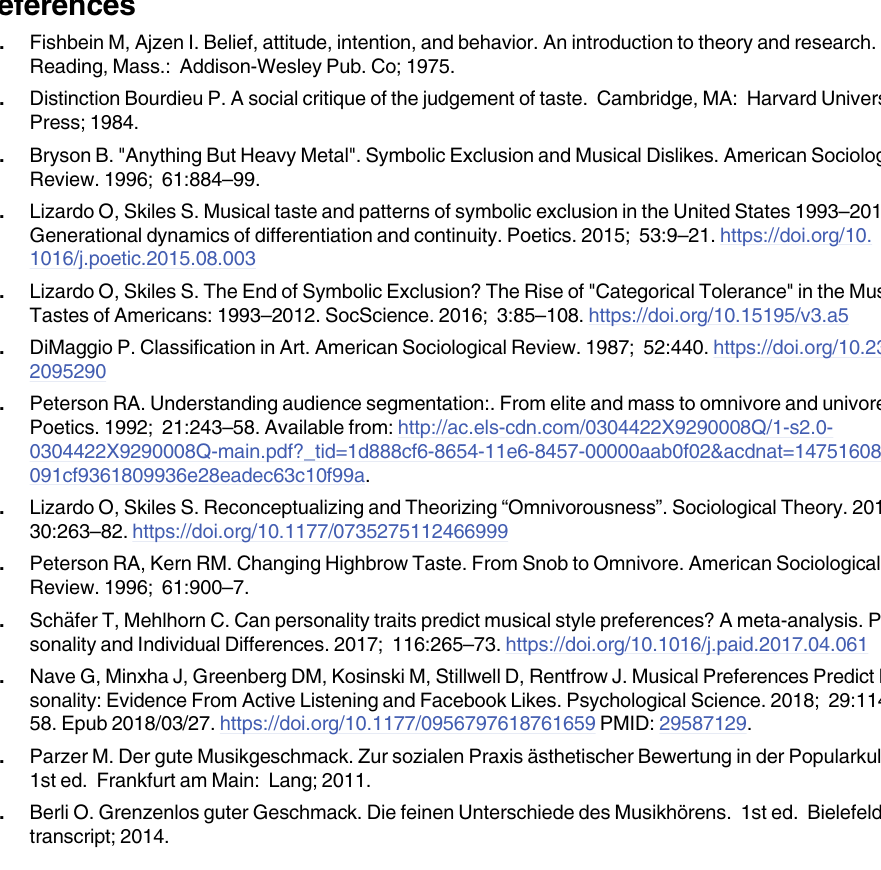
S5 Table. Sum of frequencies of reference points of disliked